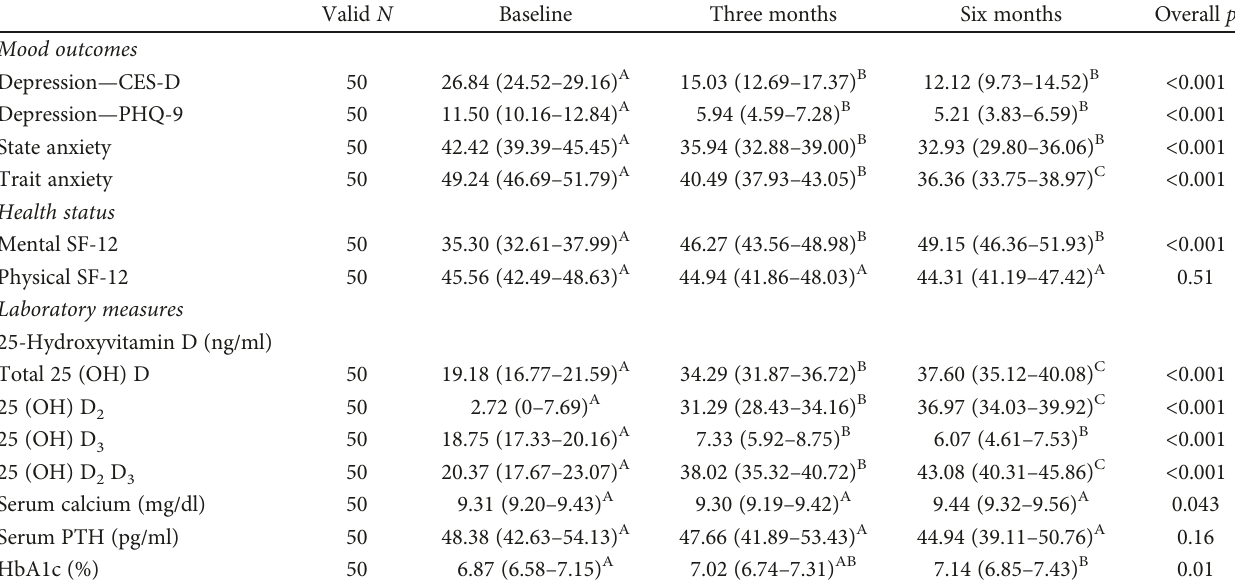
Table 2: Observed means of outcome measures over time.